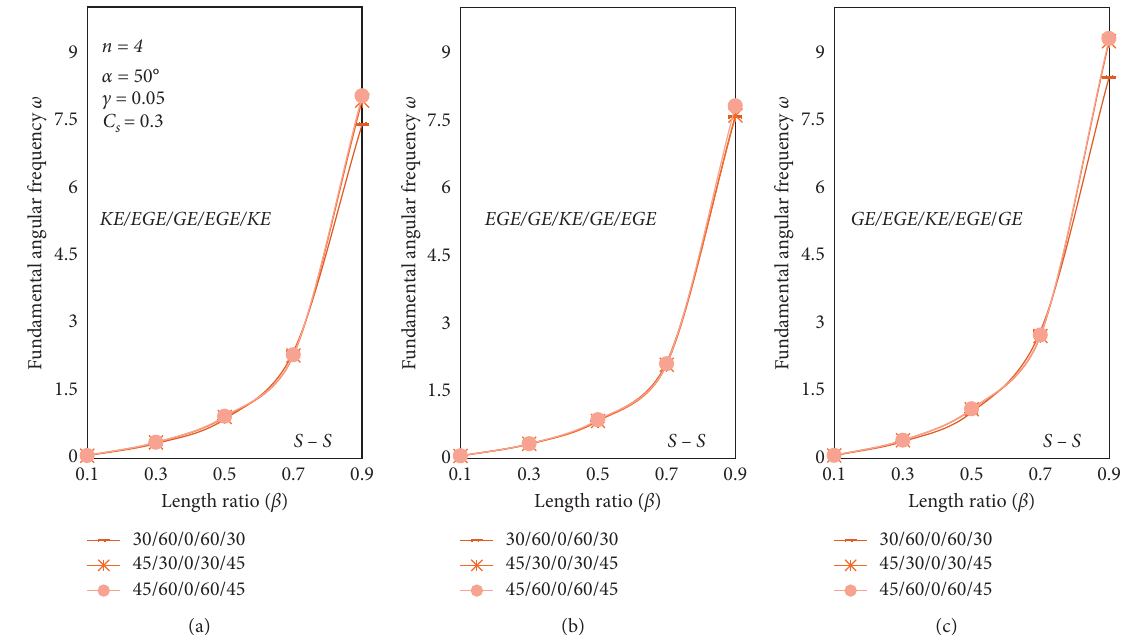
Figure 9: Influence of length ratio on the fundamental angular frequency of five-layered conical shells with different material